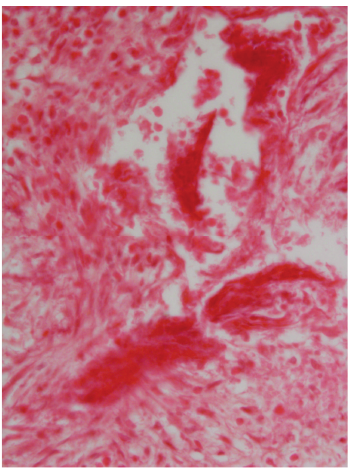
Figure 7: A section of stomach rabbit showing chronic granuloma around S. lupi in the submucosa with extensive fibrosis around the parasite and a peripheral zone of chronic inflammatory cells (H. E. original magnification × 100X).